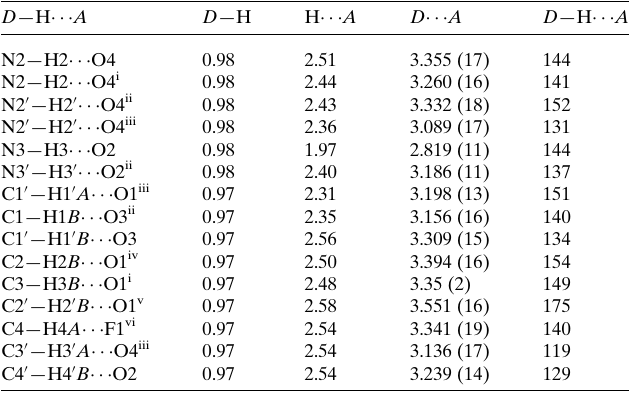
(cid:5) z ; (iv) 1 (cid:5) x , 1 (cid:5) y , 1 (cid:5) z ; (v) 3 (cid:5) x , 1 (cid:5) y , (cid:5) z ; (vii) (cid:5) 1 + x , y , 1 + z . Only one of the whole-molecule disorder 2 2 2 2 2